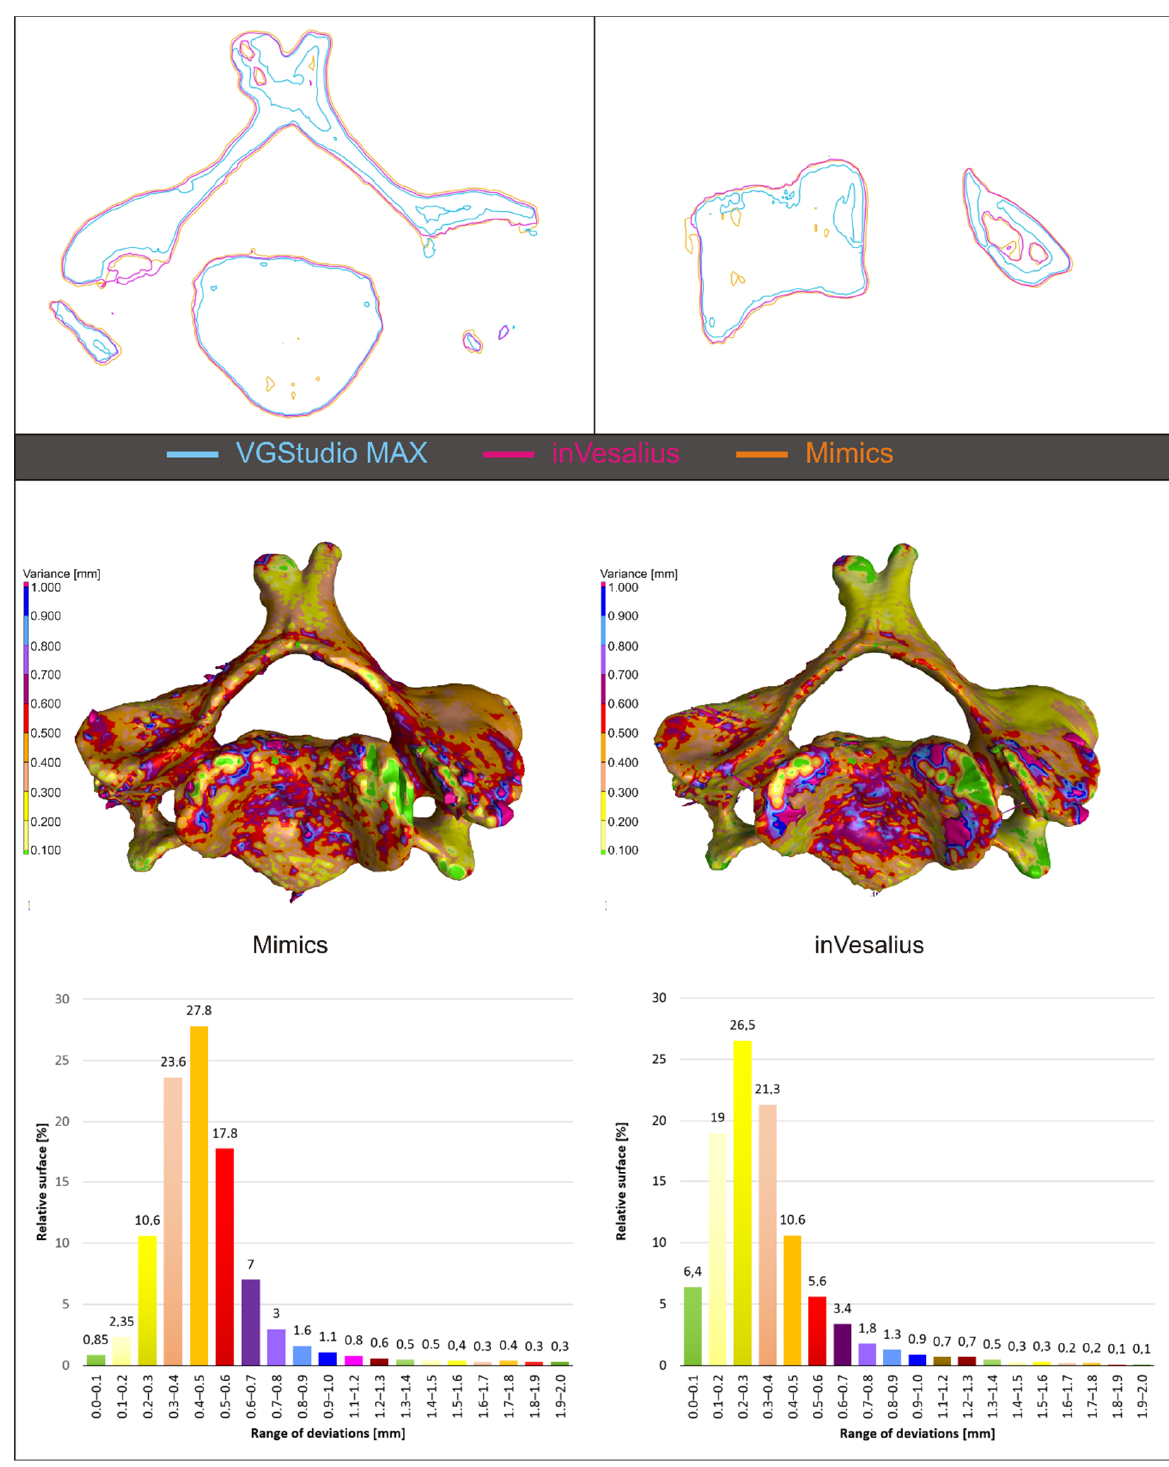
Figure 5. Model alignment and software output